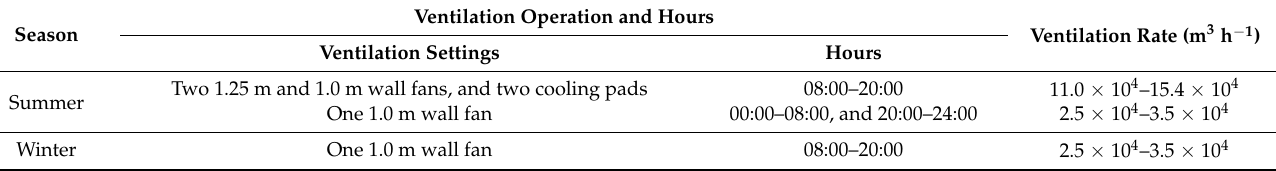
Table 1. Operation and estimated ventilation rate of the fans and cooling